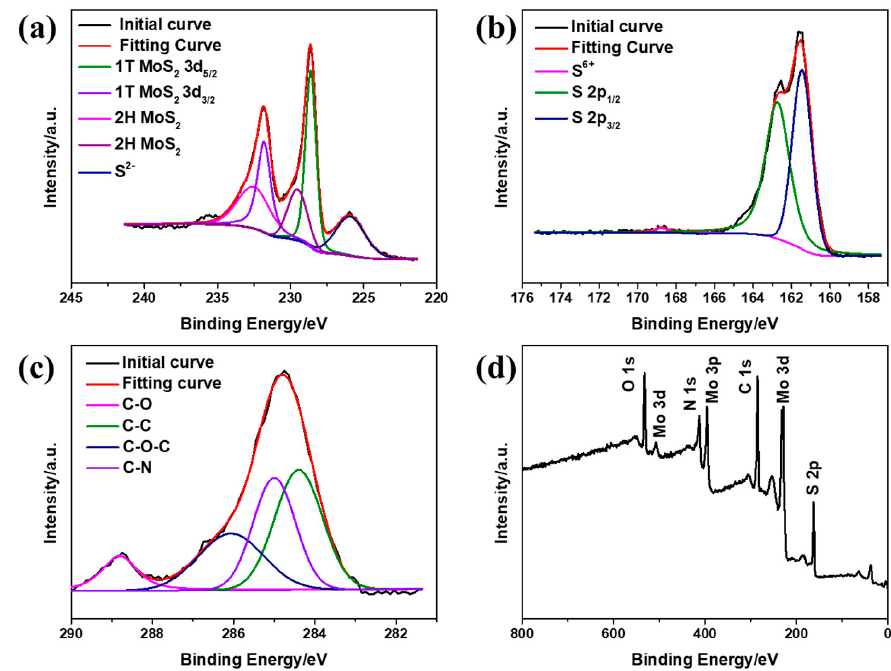
Figure 2. Peak-fitting curve of ( a ) Mo 3d, ( b ) S 2p, ( c ) C 1s, and ( d ) a survey of FR-MoS 2 /PPy.